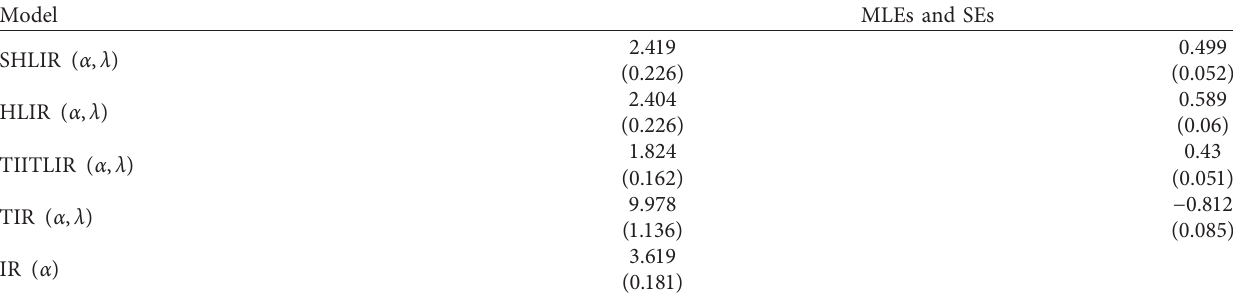
Table 4: The MLE and SE of the model parameters for data I.